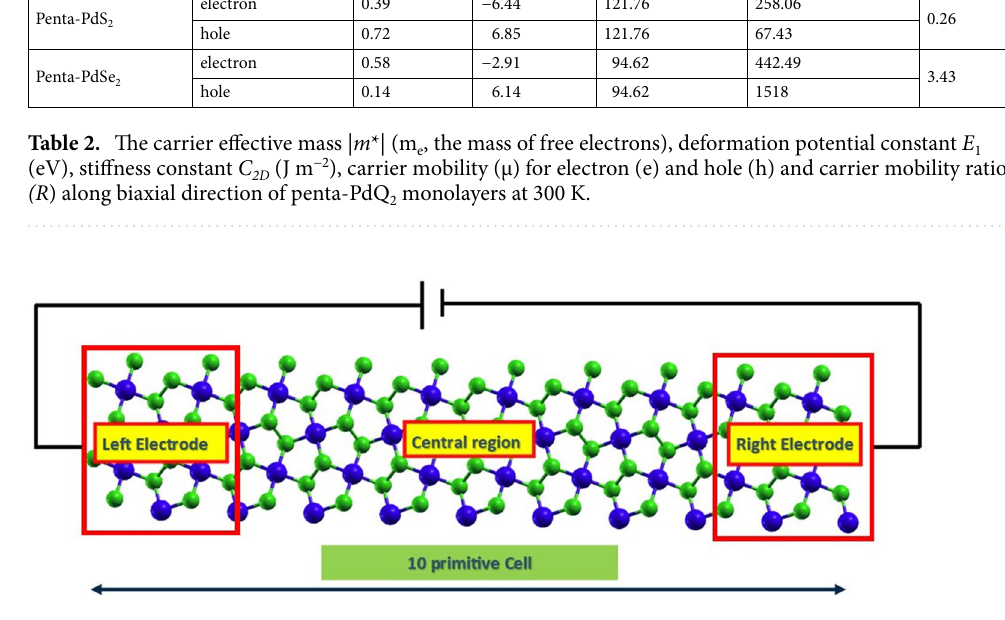
Figure 5. Schematic view of two-terminal device of penta-PdQ 2 monolayer. Here electrons are driven from the cold to the hot lead through central region.